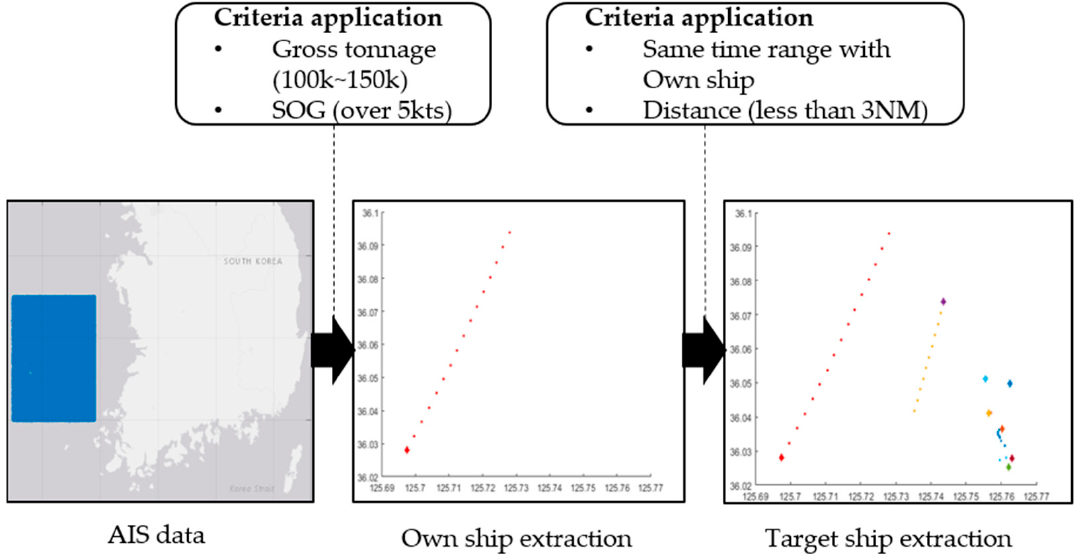
Figure 4. Trajectory extraction process.